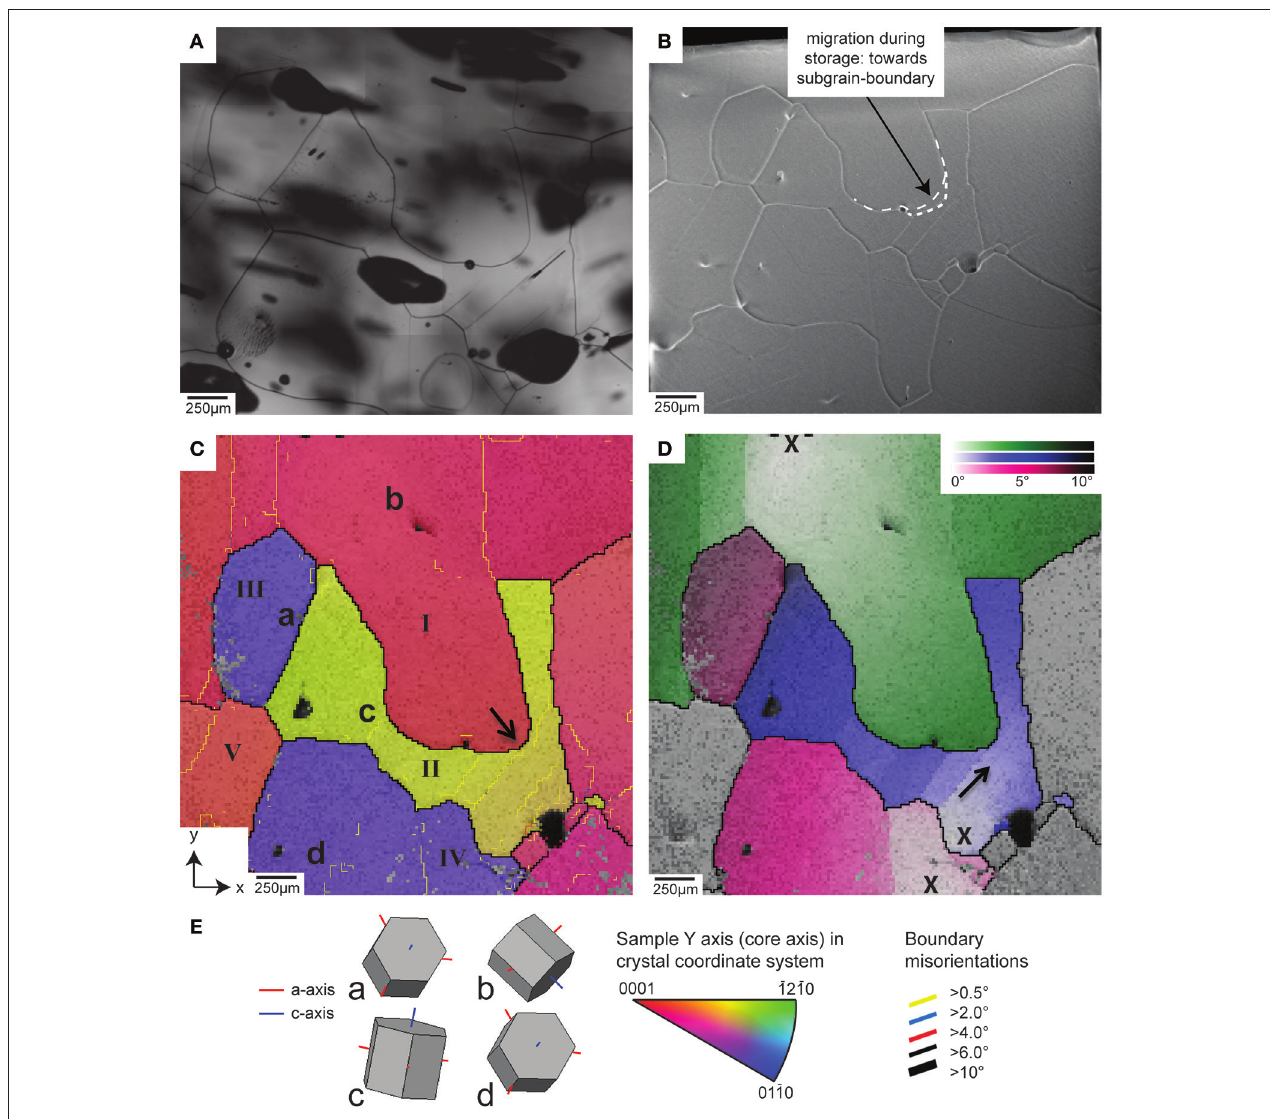
FIGURE 7 | Optical-microscopy, SEM and EBSD maps of an ice core sample at 718.8m depth in the NEEM ice core. (A) Part of the optical-microscopy image taken just after sample preparation. (B) SEM image of the mapped part of the EBSD sample with the edge of the EBSD sample in the upper part of the image. (C) EBSD map, with the y-axis parallel to the (vertical) core axis. (D) Map showing the orientation difference of up to 10 ◦ relative to the three spots marked with “X.” (E) Schematic illustration of measured full CPO (c- and a-axes) at positions (a–d), and color codes for CPO and boundary misorientation.